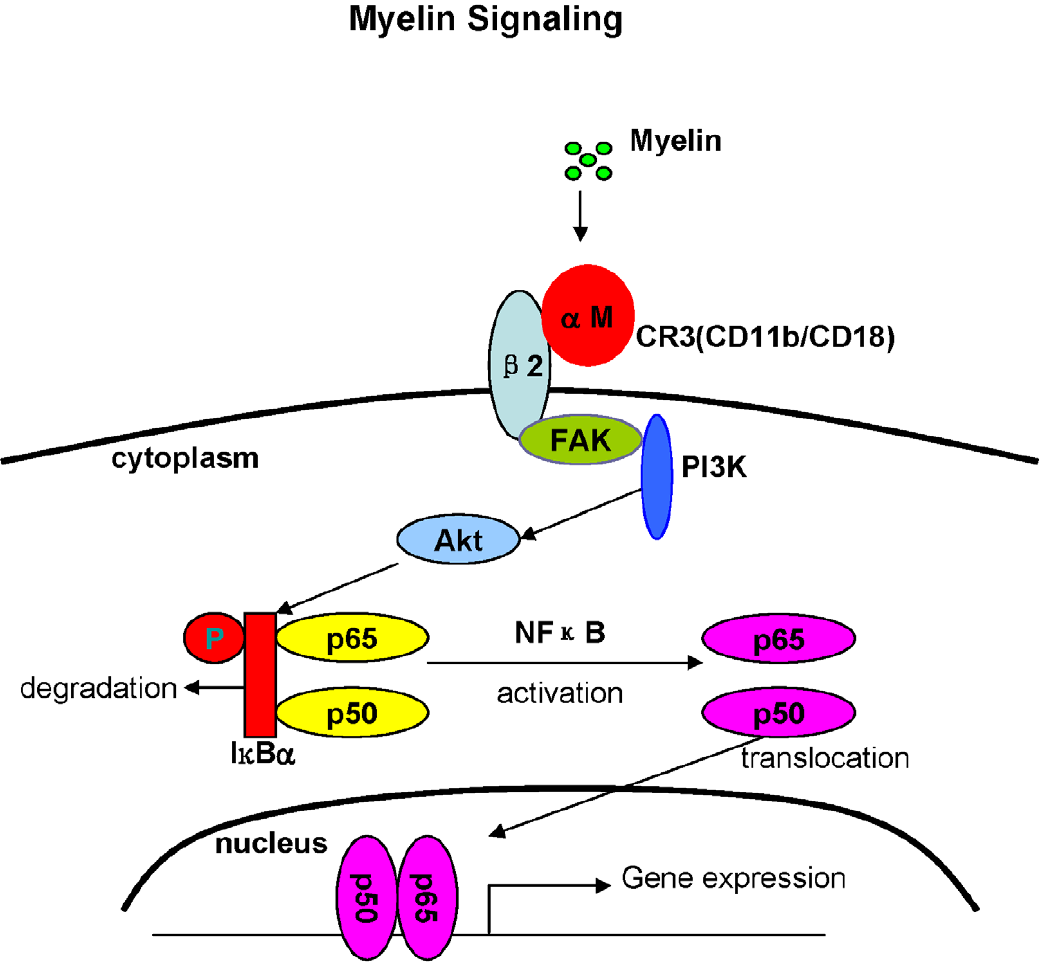
Figure 10. Schematic diagram depicting the possible mechanism that myelin induces inflammatory responses. Myelin debris generated in injured CNS or demyelinating diseases may bind to CR3 and then activate NF- k B through FAK/PI3K/Akt pathway, therefore initiating gene expression of pro-inflammatory mediators.